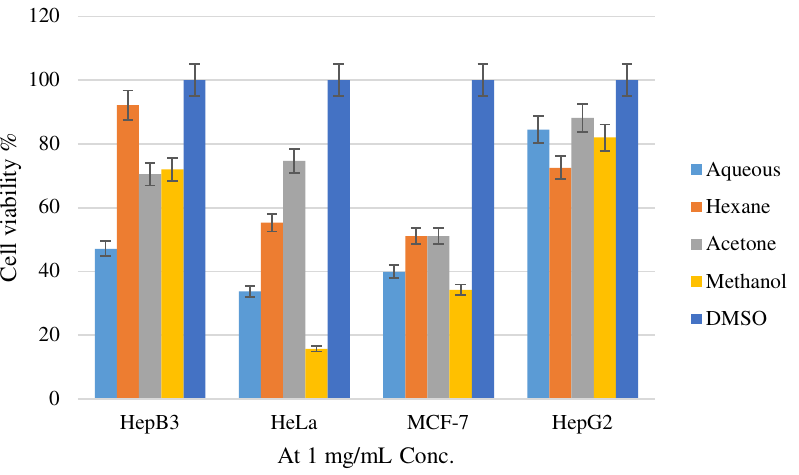
Figure 1. Cell viability % of H. lanuginosum methanol, aqueous, hexane, and acetone extracts. Table 4. Cytotoxic activity IC 50 values ( µ g/mL) of H. lanuginosum methanol, aqueous, hexane, and acetone extracts compared with the positive control chemotherapy drug doxorubicin. Samples